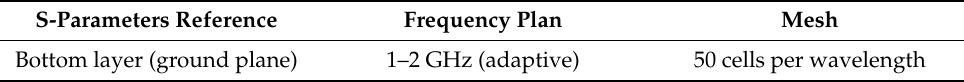
Figure 4. SMA connector: ( a ) presentation of the connector; ( b ) proposed equivalent circuit.